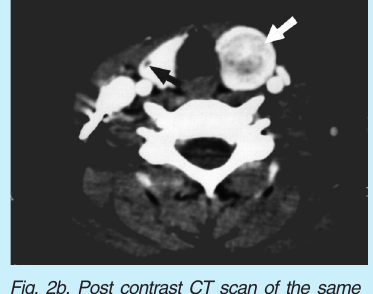
Fig. 2b. Post contrast CT scan of the same region demonstrates inhomogeneous enhancement of the larger nodule (white arrow) making it more difficult to differentiate from normal parenchyma. The small right lobe lesion does not enhance and is now more evident (black